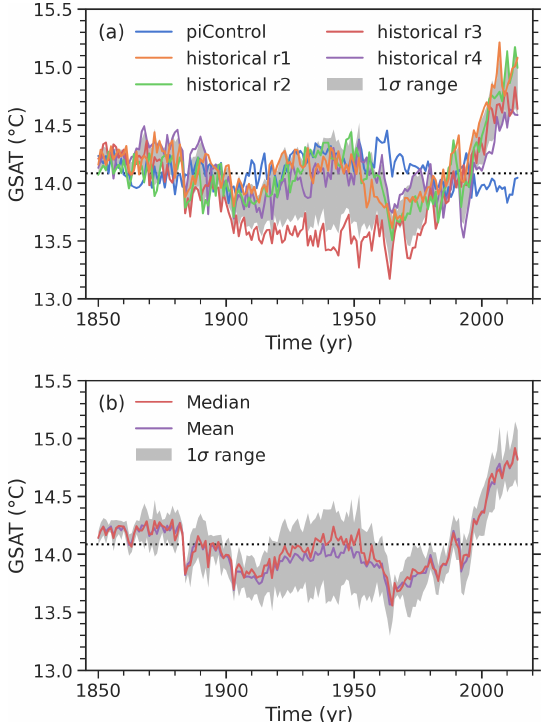
Figure 5. Time series of the annual and global mean surface air temperature for the four realizations of the CMIP6 historical sim- ulation (a) , and the corresponding ensemble median and mean val- ues (b) . In both panels, the gray area indicates the range bounded by 1 standard deviation around the ensemble mean, and the dotted line indicates the preindustrial mean of 14.08 ◦ C. For comparison, panel (a) also shows the corresponding time series for the first 165 years of the preindustrial control